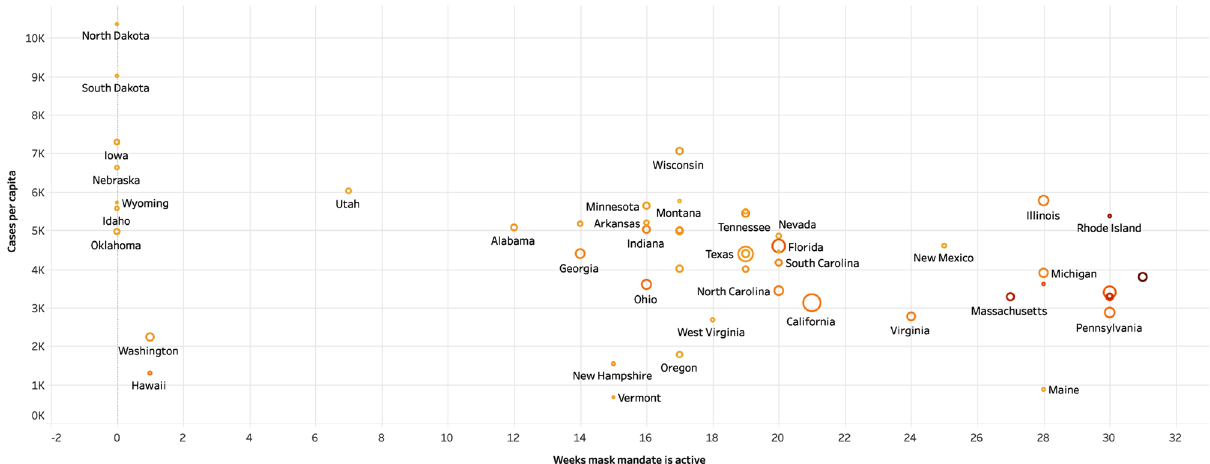
Figure 4. Relationship between the number of cases per capita and the number of weeks a mask mandate is active in a state.